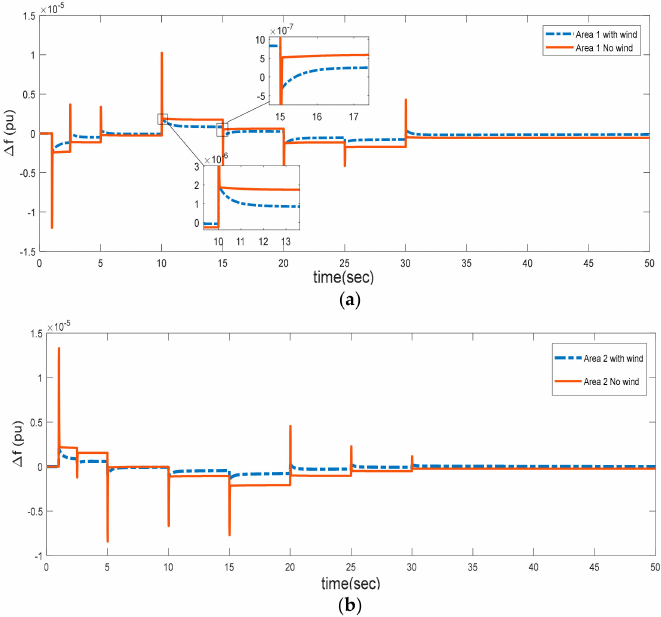
Figure 10. Dynamic response of EID with wind farm participation and EID without wind farm participation ( a ) response of Area 1; ( b ) response of Area